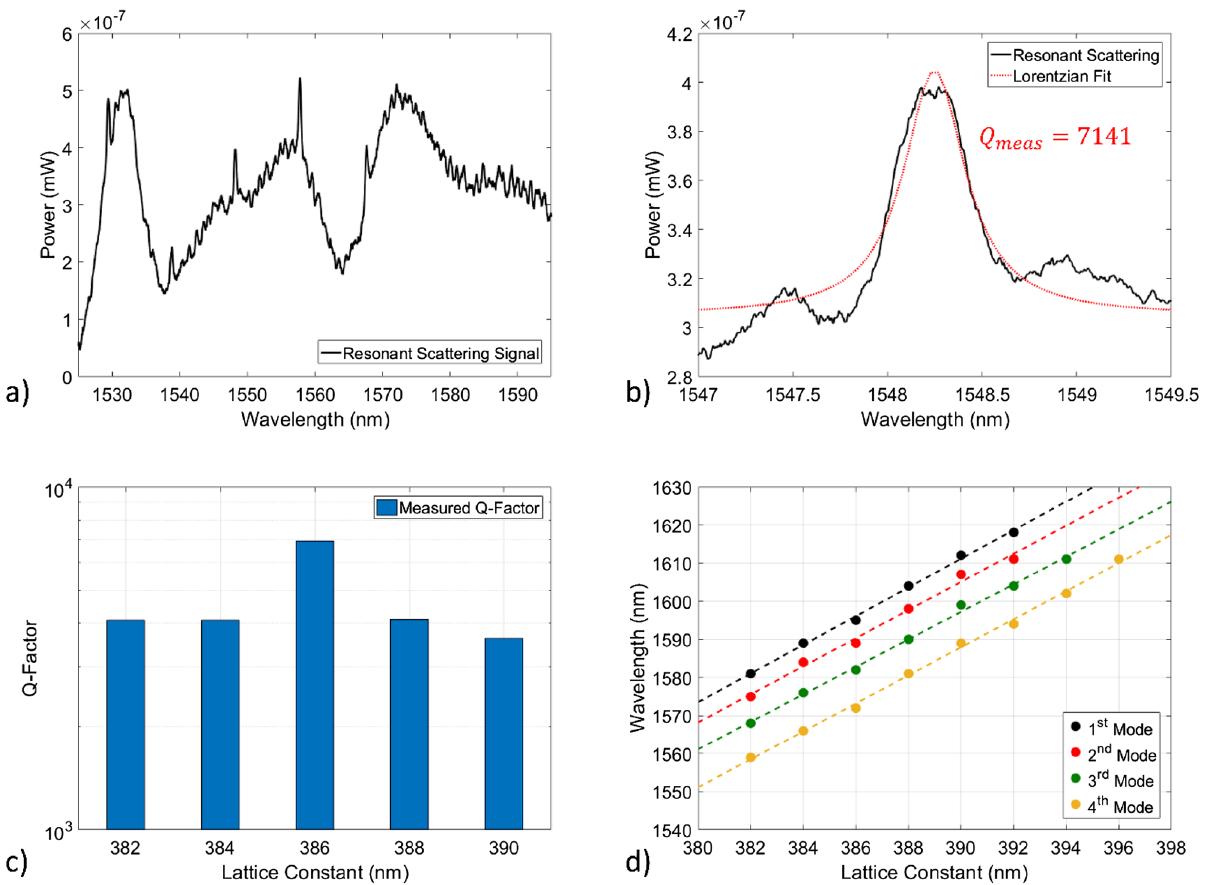
Figure 10. (a ) Optical spectrum of an L3 PhC measured through resonant scattering technique, ( b ) Spectrum of the measured fundamental mode of ( a ) in which the red curve represents a Lorentzian fit of the resonance, ( c ) Measured Q-factors of L3 cavities with lattice constant increasing with a 2 nm step, ( d ) Resonance wavelength of the optical modes of the L3 PhC cavity versus lattice constant, in which different colours represent different measured